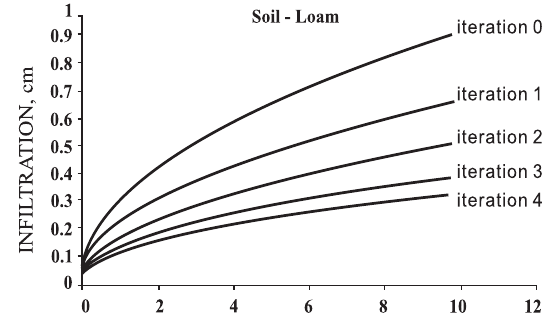
materials.Figure 5. Infiltration rate as a function of time for loam material at each iteration level (clay content is zero at iteration zero and increases with each iteration).